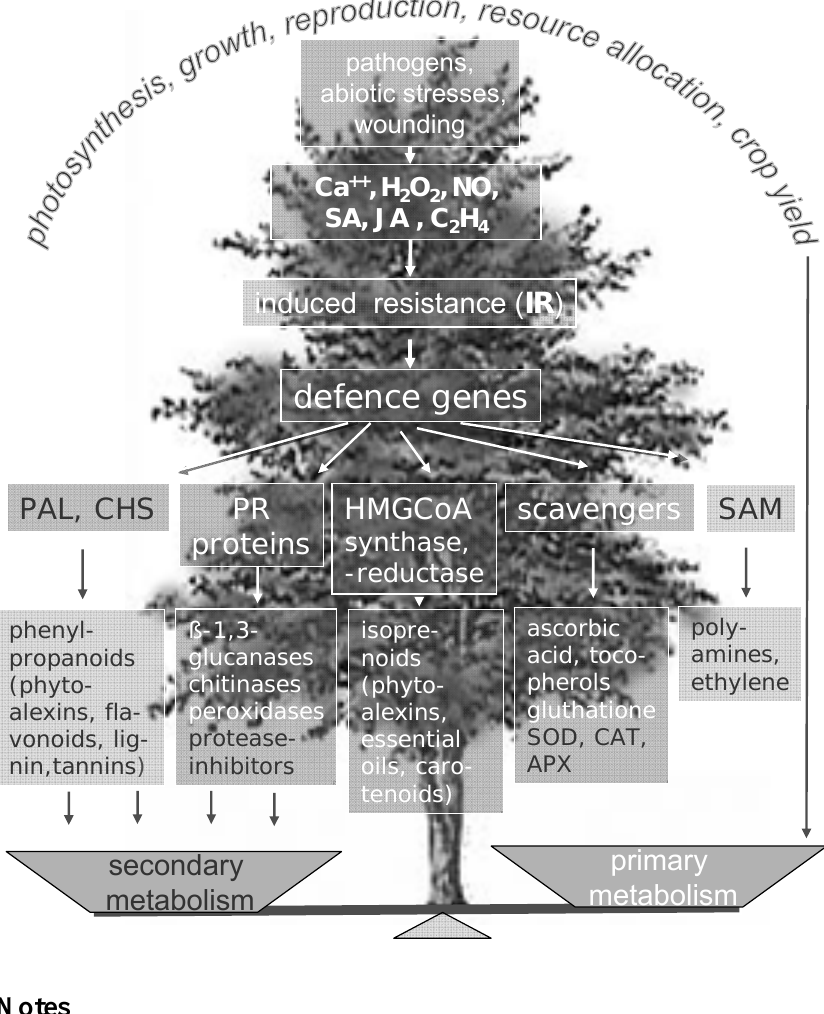
Figure 5. Influence of different stresses on plant metabolism. The activation of induced resistance leads to the accumulation of numerous defence compounds that may unbalance the equilibrium between primary and secondary metabolism, thus resulting in fitness costs for the plant. On the other hand, the synthesis of secondary metabolites due to a stress may protect plant from other different